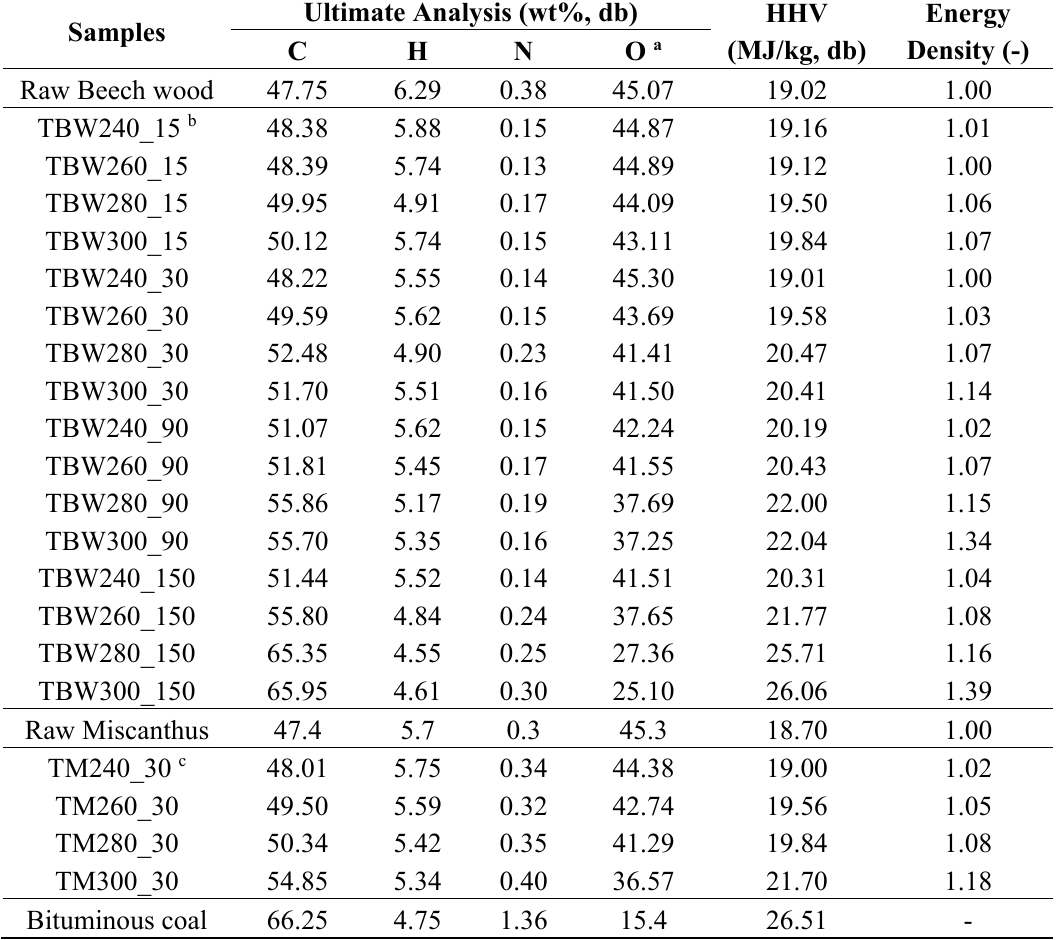
Table 2. Heating value and ultimate analysis of torrefied beech wood and miscanthus at various temperatures and residence